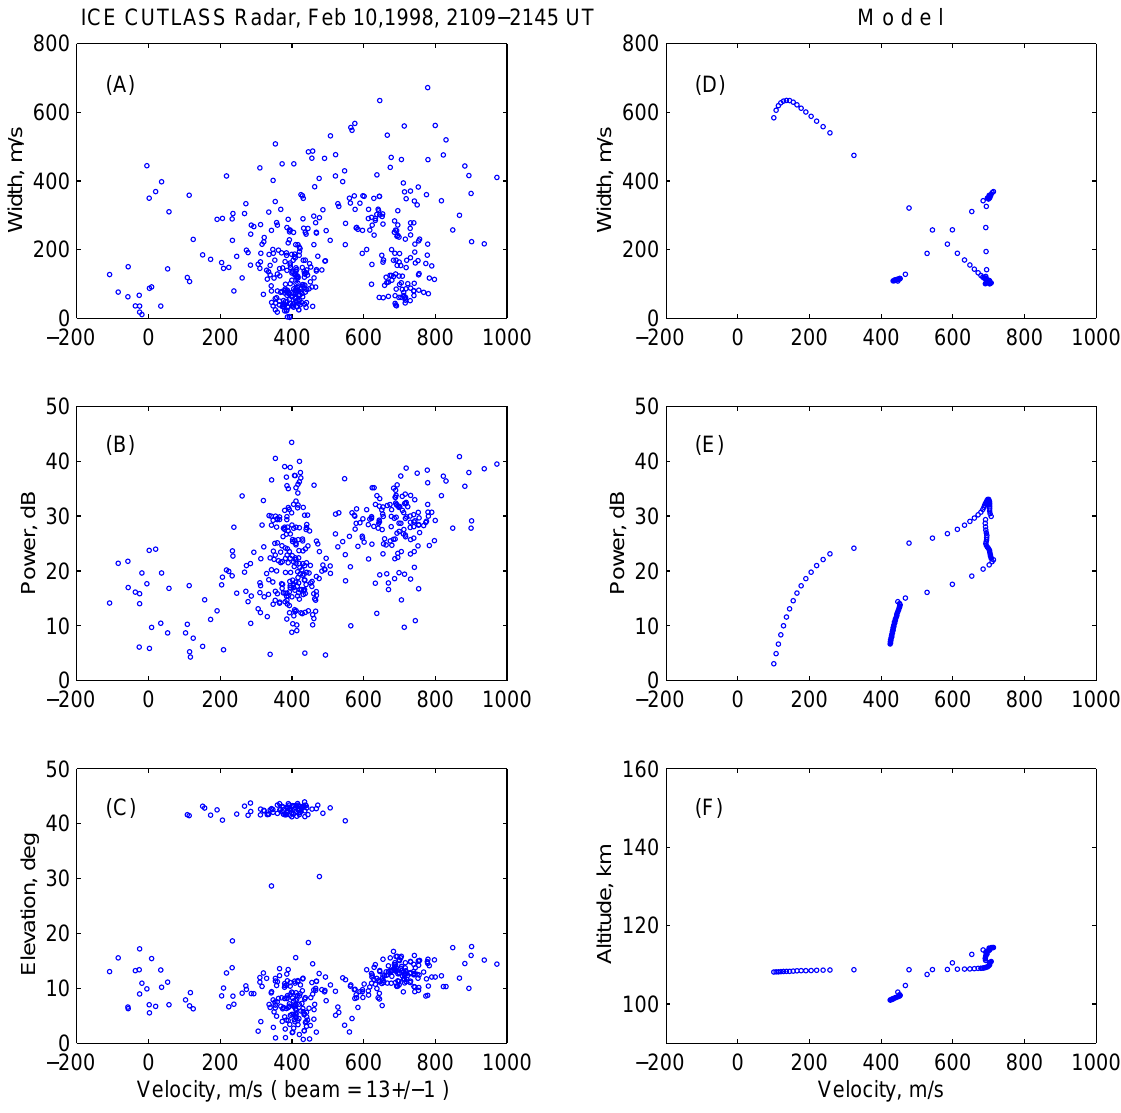
Fig. 4. Scatter plots illustrating width-velocity, power-velocity and elevation angle/altitude-velocity relationships, as observed (a-c) and as predicted by the model (d-f)